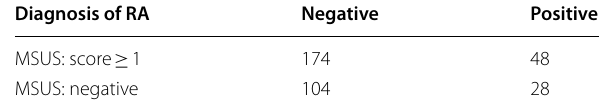
Diagnosis of RA